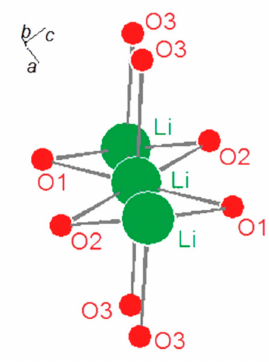
Figure 8. Ions di ff usion path along the (010) lattice direction of the olivine phase. The shown O1, O2 and O3 oxygen atoms (4c / 4c / 8d lattice sites, respectively) are the closest first neighbors of the Li-centres (4a lattice site) and limit the size of the di ff usion